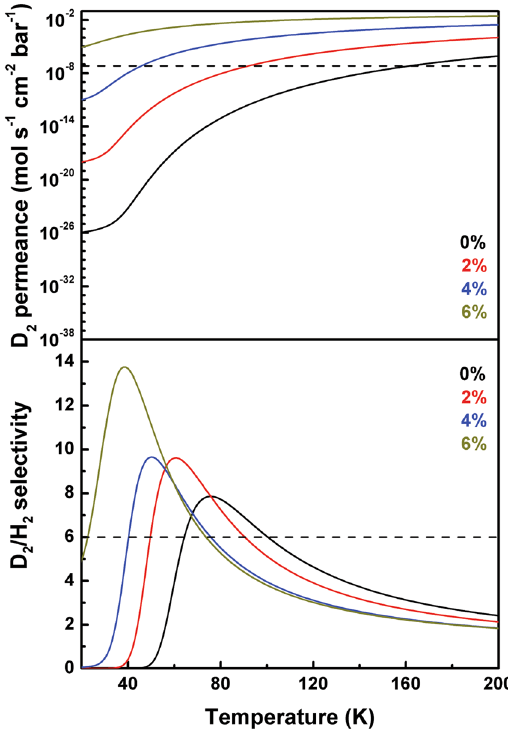
Figure 3. The D 2 permeance and the kinetic selectivity under different strains for temperature ranging from 20 to 200 K. Different colors indicate different strains ranging from 0% to 6%. The dashed lines indicate the industrial-acceptable values for permeance (6.7 × 10 − 8 mol/s/cm 2 /bar) and selectivity (6),